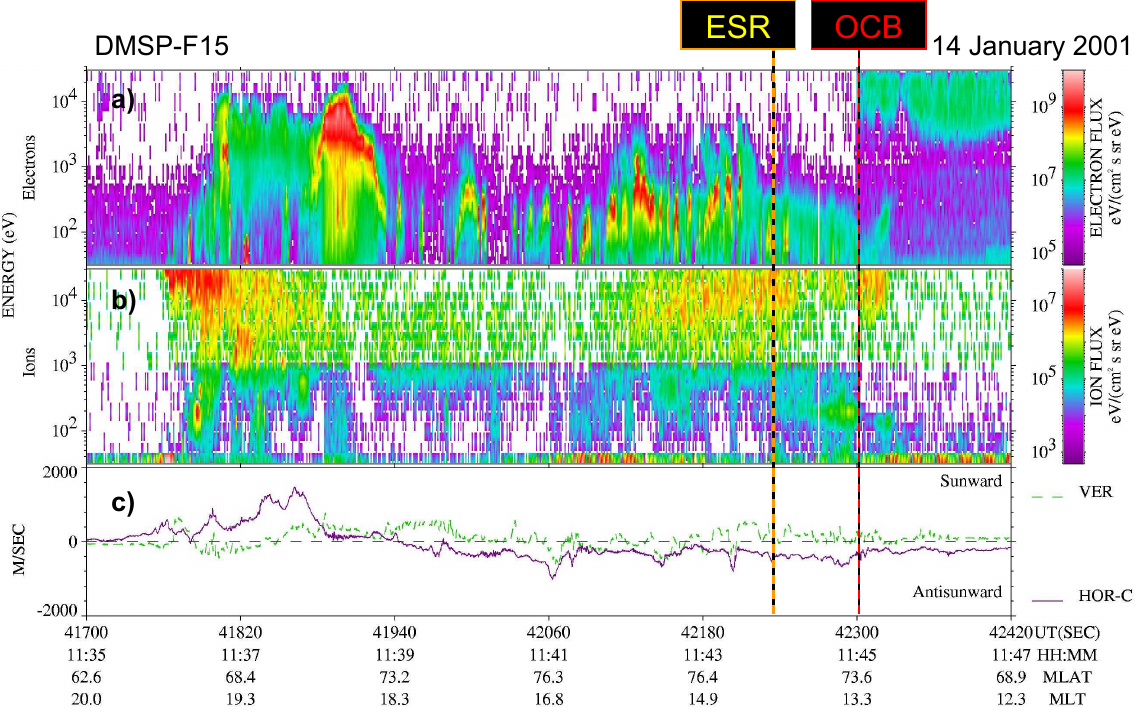
Fig. 4. Energy-time spectrograms for (a) electrons and (b) ions observed by DMSP-F15 as it passed equatorward in close conjunction with the ESR along the path shown in Fig. 5. In both cases, the differential energy flux is plotted as a function of energy (increasing upward) and observation time, t s . (c) Shows the vertical (green) and horizontal (purple) components of the ion velocity (the horizontal component is perpendicular to the satellite track such that positive values have a sunward component and negative values have an anti-sunward component. The orange-and-black dashed line gives the time of closest conjunction with the ESR field-aligned beam and the red-and-black line gives the open-closed field line boundary (OCB) defined from the energetic magnetospheric